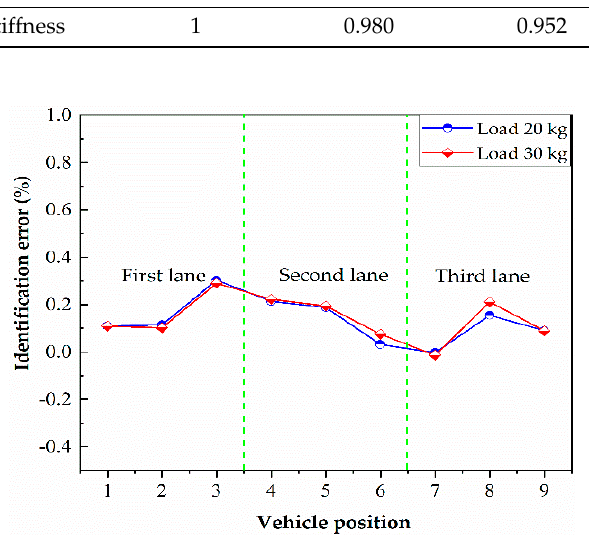
Figure 9. Identification results considering the load transverse